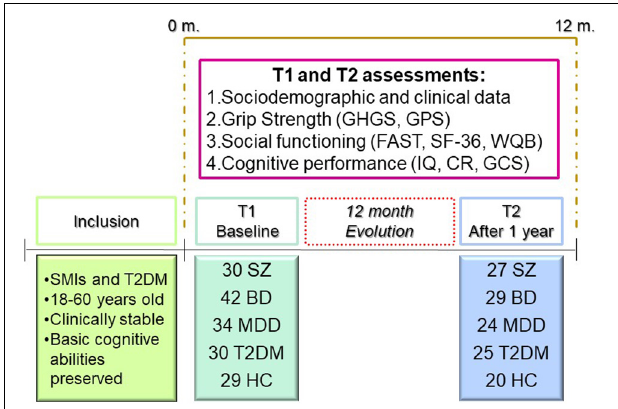
FIGURE 2 | Research